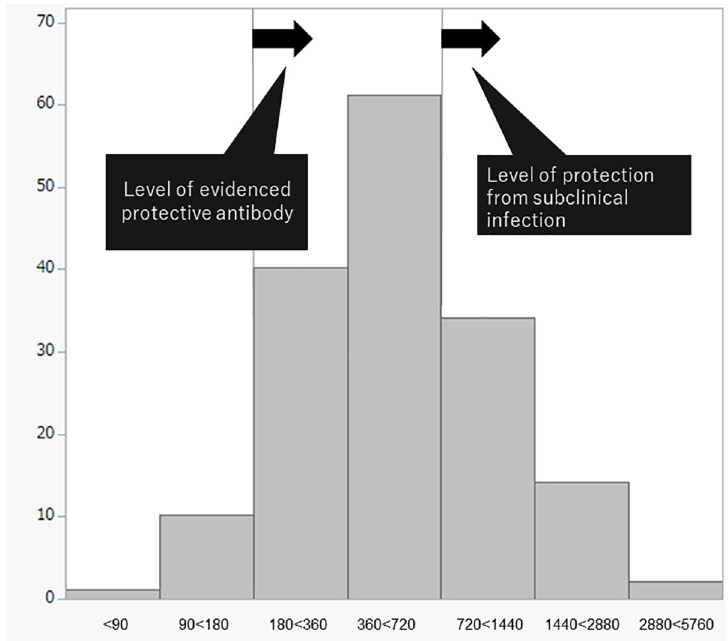
Fig 2. The distribution of measles antibody titers of the subjects (n = 162). The X-and Y-axes show the measles antibody (mIU/mL) and the number of participants, respectively.